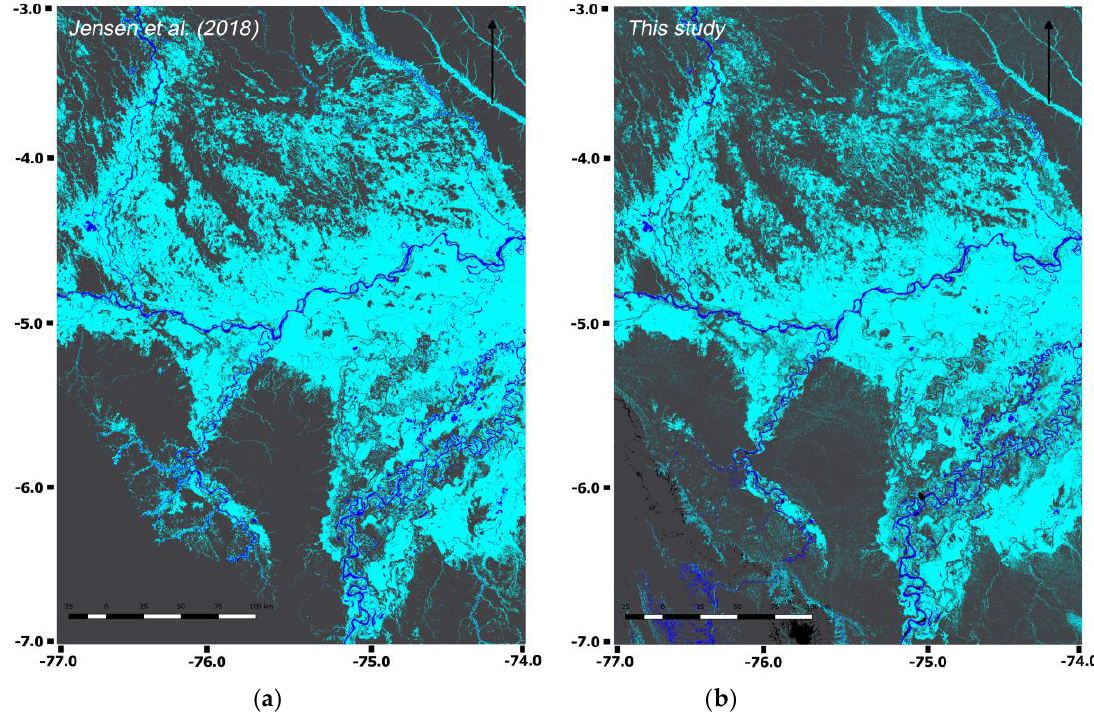
Figure 9. Classification images of Pacaya-Samiria. Light blue: inundated vegetation; blue: open water; grey: non-flooded/masked areas/no data. ( a ) Classification by Jensen et al. [16]. ( b ) Classification in this study.